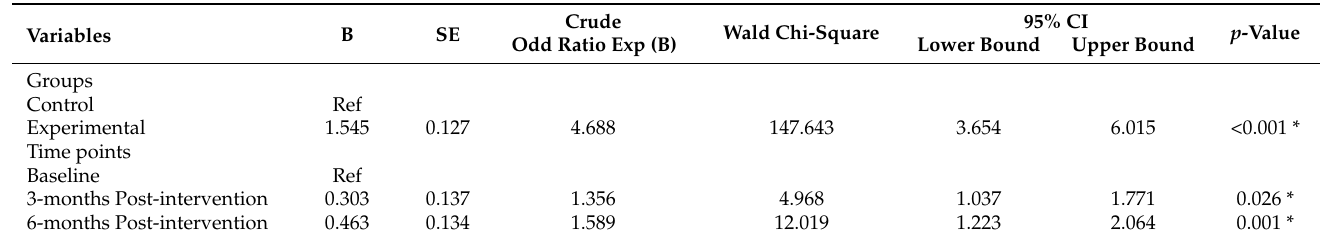
Table 8. Comparison of Food Security towards Malnutrition between Groups and Time Points (baseline to three and six-months) respectively using